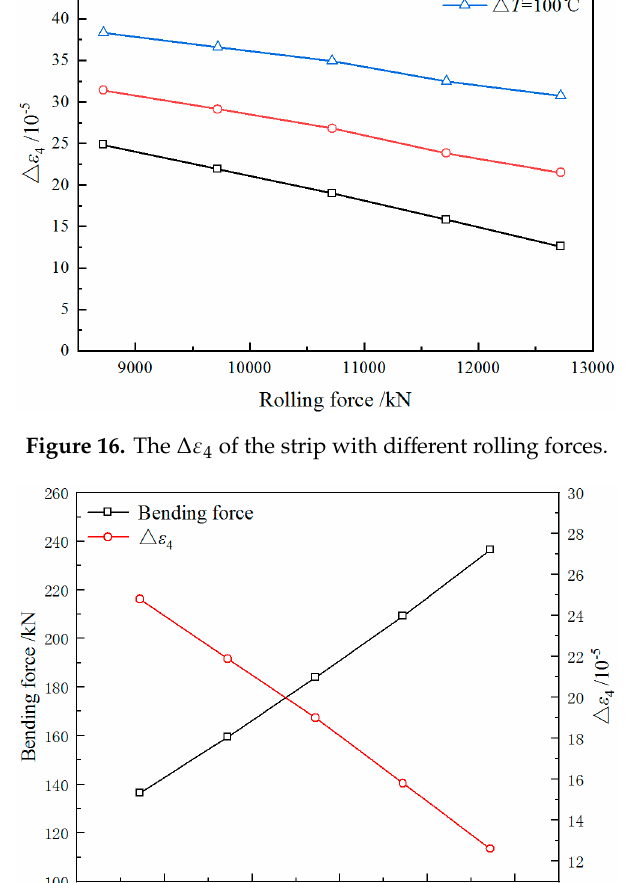
Figure 17. Bending force and the Δ ε 4 of the strip with different rolling forces ( Δ T = 50 °C).